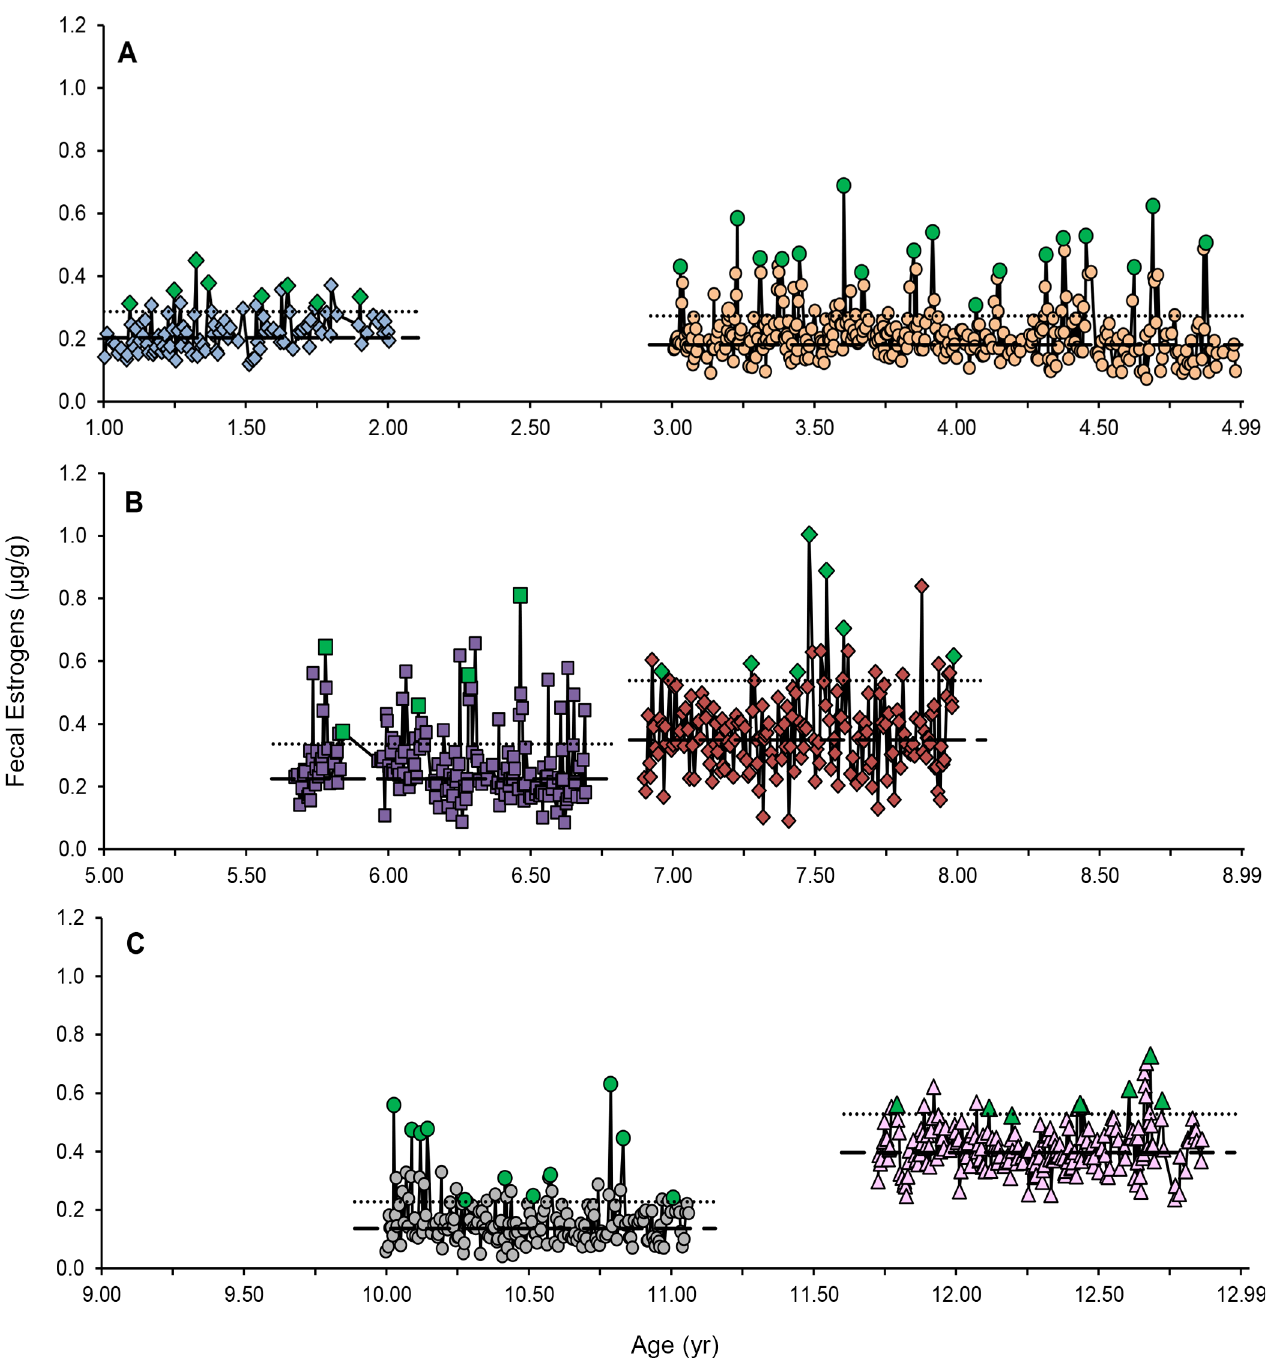
Fig 1. Fecal estrogen metabolite ( μ g/g) profiles of six females of diverse ages. Panel A: SB408, blue diamonds and SB247, orange circles; Panel B: SB205, purple squares and SB235, red diamonds; Panel C: SB140, grey circles and SB76, pink triangles. Baseline (dashed line) and threshold (dotted line) concentrations were calculated for each female. Estrous peaks are denoted with green data